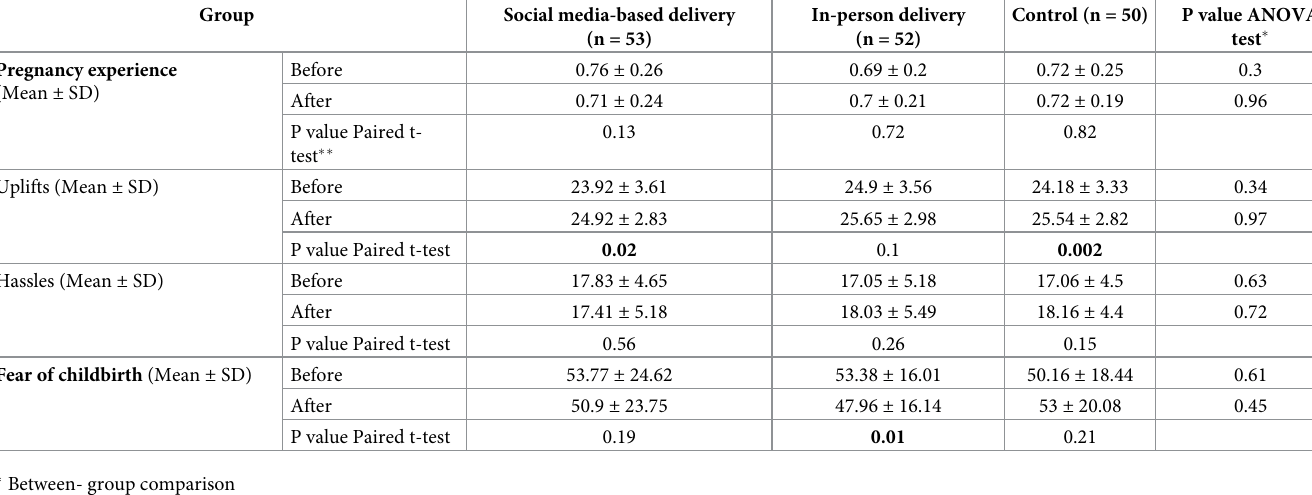
Table 3. Within-group and between-group comparisons of pregnancy experience and FOC in three groups before and after the intervention. Group